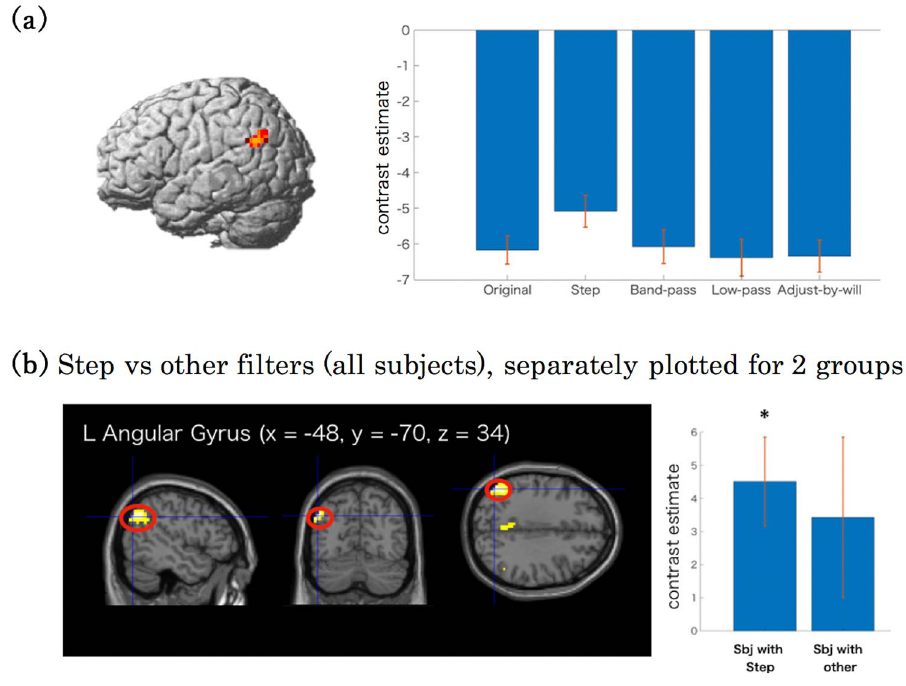
Figure 4. Effects of filter type. ( a ) Left: Significant voxels from ANOVA for the main effect of filter condition, yielding extensive clusters in the left inferior parietal lobes, with peak voxels in the left angular gyrus. Right: Contrast estimate for each filter condition in the left angular gyrus. Displayed contrasts were significant at a voxel-level threshold of p < .001, uncorrected. ( b ) Left: Significant voxels for step filtered voice—other contrast. The left angular gyrus showed a contrast peak. Right: Difference in the contrast estimates in the left angular gyrus between the step filter condition and the other filters. Sbj with Step: Subjects who scored high on the step filter. Sbj with other: Subjects who scored high on the other filters. Displayed contrasts were significant at a voxel-level threshold of p < .001 combined with an FWE correction of p < .05 for cluster size. The error bars represent 90% confidence